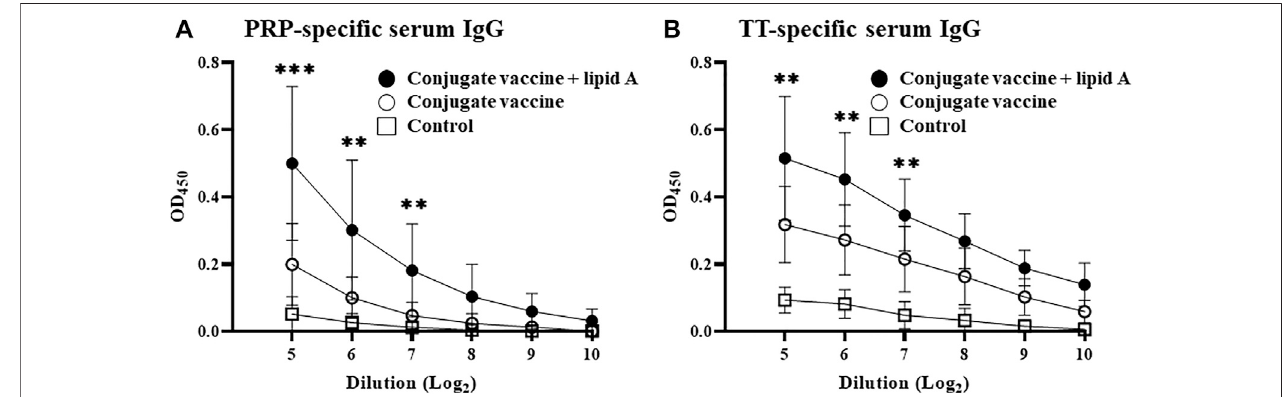
FIGURE1| Alcaligenes lipidAenhancedantigen-speci fi cIgGproductionin Haemophilus Bconjugatevaccination.MicewereimmunizedsubcutaneouslywithPBS (control group) or Haemophilus B conjugate vaccine containing 0.01 μ g of PRP with or without 1 μ g of Alcaligenes lipid A. Serum was collected 1 week after the fi nal immunization, and the levels of (A) PRP-speci fi cIgG and (B) TT-speci fi c IgGwere measured byELISA ( n (cid:2) 11/group). The results shown are presented asmean ± 1SD. Data are representative of two independent experiments, and statistical signi fi cance was evaluated by using one-way ANOVA (**, p < 0.01; ***, p < 0.001; the asterisks represent the signi fi cant difference between two experimental